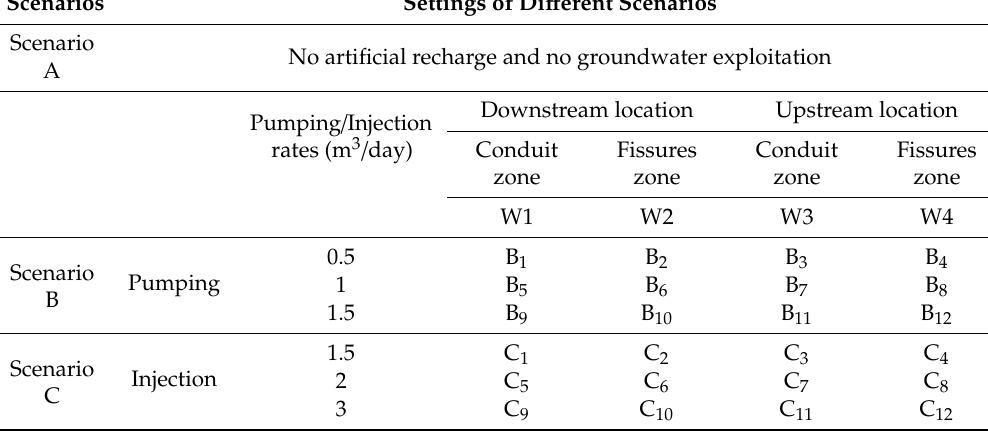
Table 1. Definitions for di ff erent